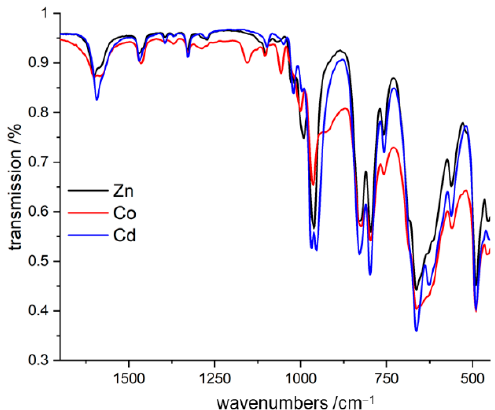
Figure 5. The IR spectra of the title compounds in the fingerprint region.